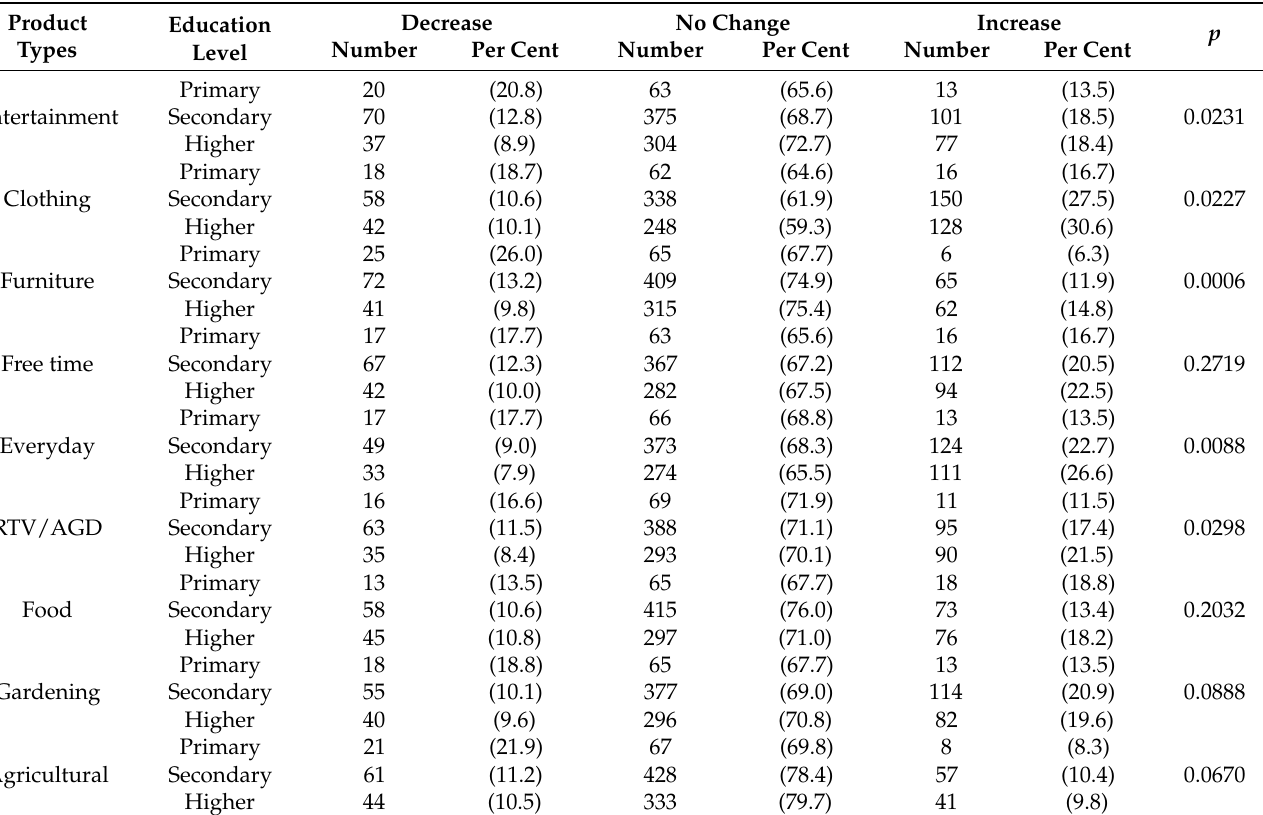
Table 7. Relation between the education level of rural e-customers and the frequency of online purchases before and during the COVID-19 pandemic (own elaboration).